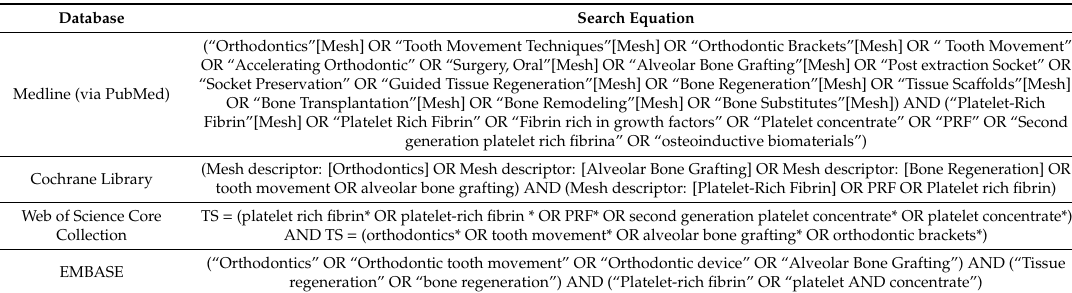
Table A1. Search Strategy for each of the databases